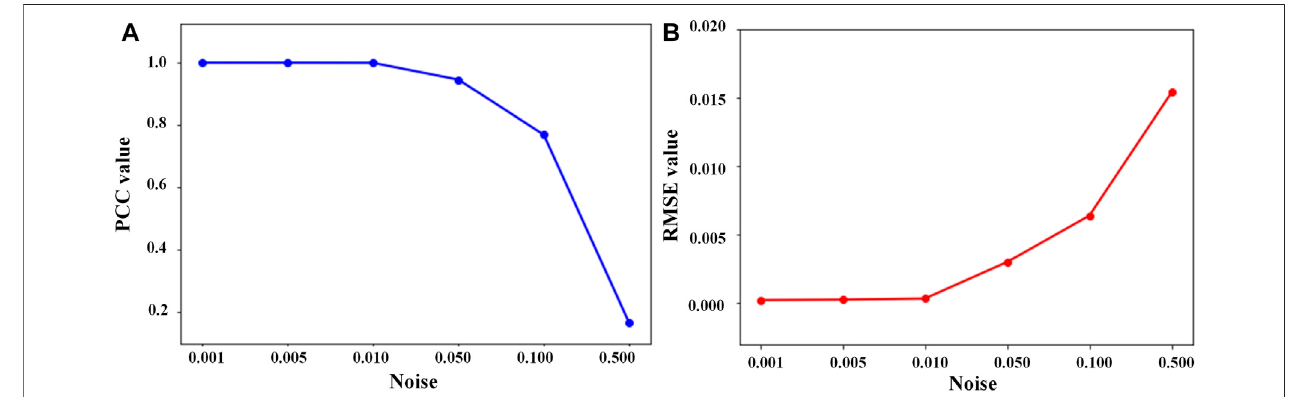
FIGURE8| PCCandRMSEvaluesbetweenpredictiveandtruedataunderdifferentnoiseintensities.Thedetailsarelistedin SupplementaryTableS3.7 . (A) PCC valuebetweenpredictiveandtruedata,wheretheabscissarepresentsthenoiseintensityandtheordinaterepresentsthePCCvalue. (B) RMSEvaluebetweenpredictive and true data, where the abscissa represents the noise intensity and the ordinate represents the RMSE